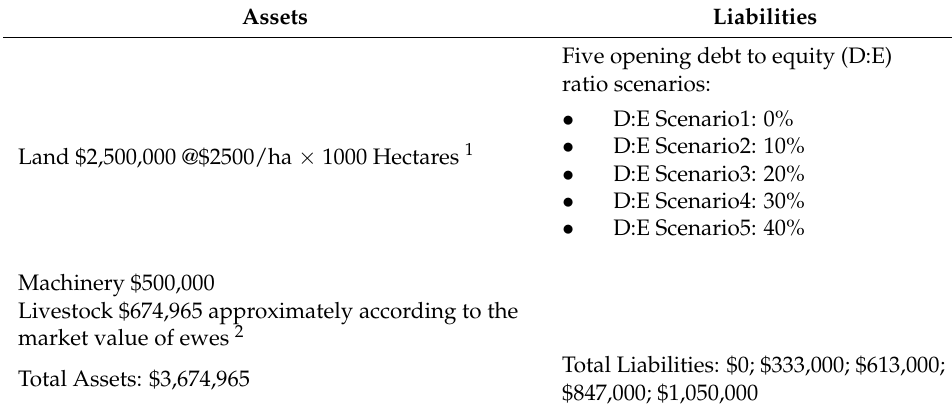
Table 1. Opening balance